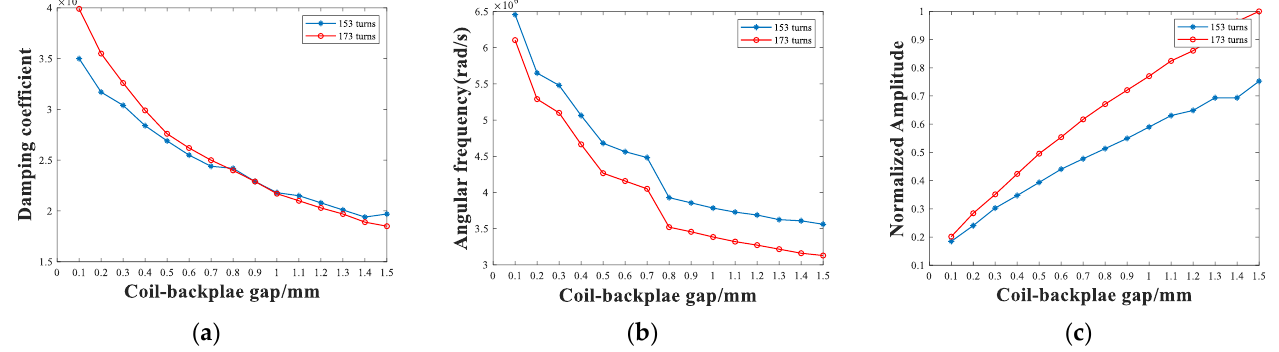
Figure 13. The ( a ) damping coefficients, ( b ) damped-oscillation angular-frequencies, and ( c ) ampli- tudes of EMATs with different receiving coil – backplate gaps.